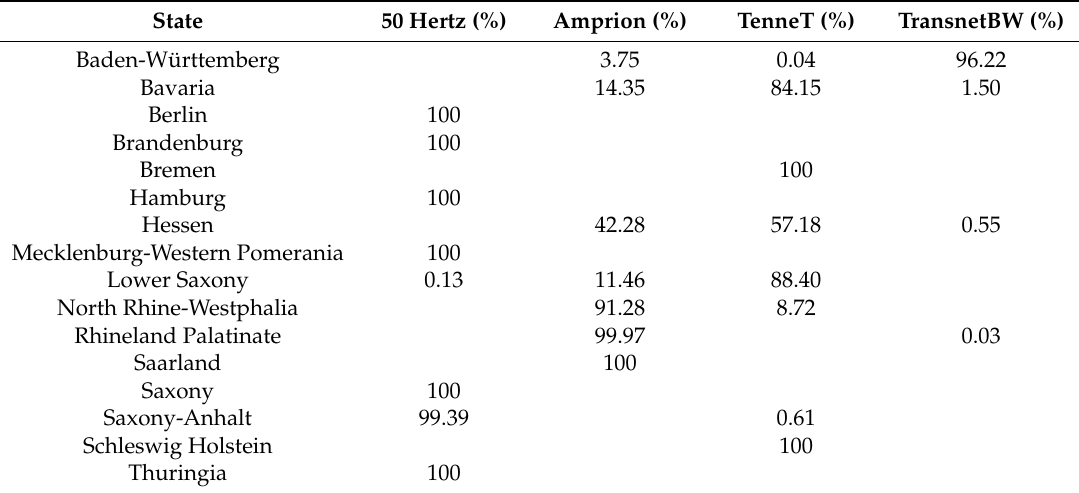
Table 4. Share of the TSO in each state in terms of supplied